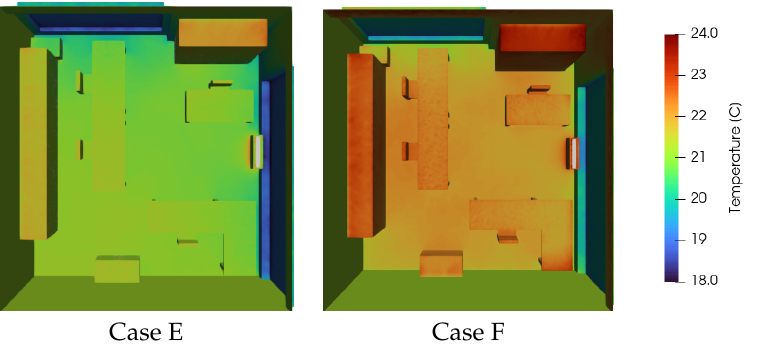
Figure 8. Top view of the internal temperature profile obtained for winter heating with low input air velocity (Case E) and high input air velocity (Case F).